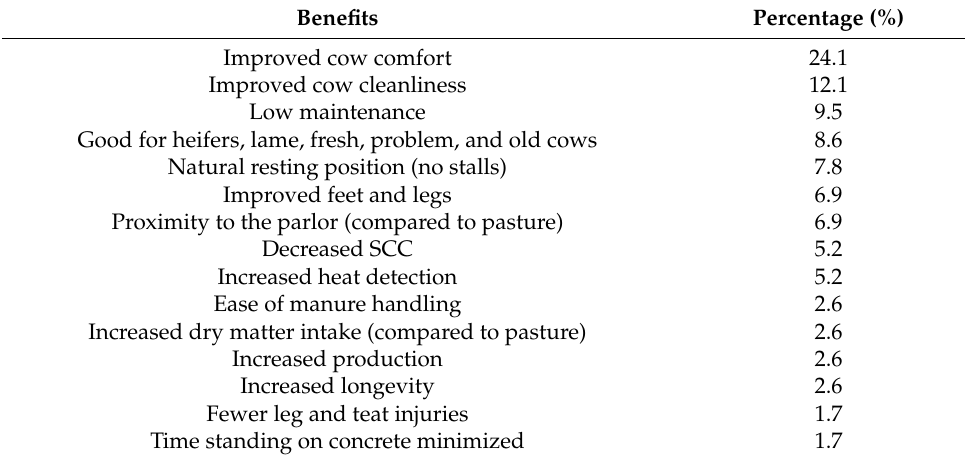
Figure 7. Herd size and number of dry cows in 42 CBP barns. Table 1. Producer-cited benefits of 42 CBP